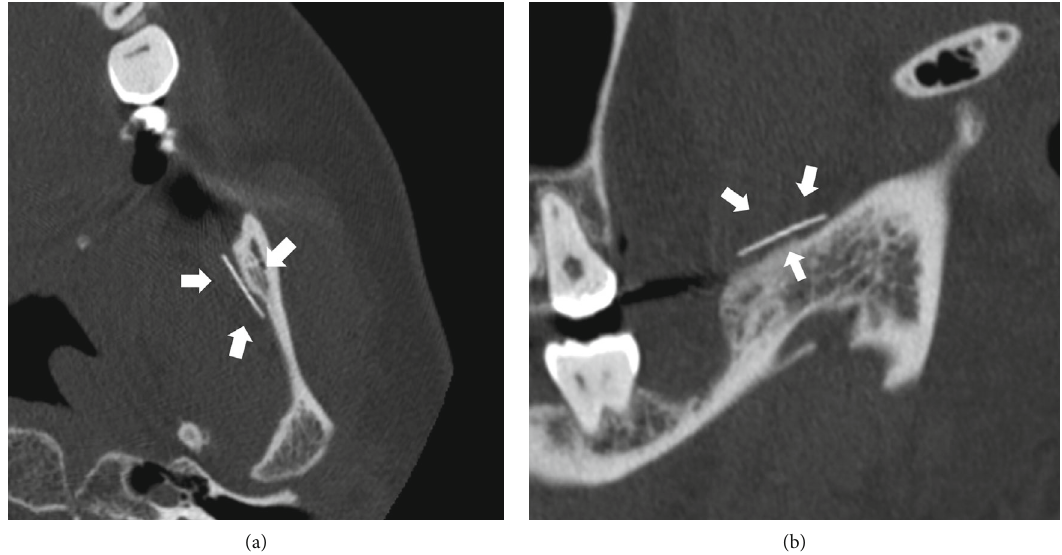
Figure 2: (a) Computed tomography (axial). The broken injection needle can be seen at the base of the left coronoid process (arrows). (b) Computed tomography (sagittal). The broken injection needle can be seen at the base of the left coronoid process